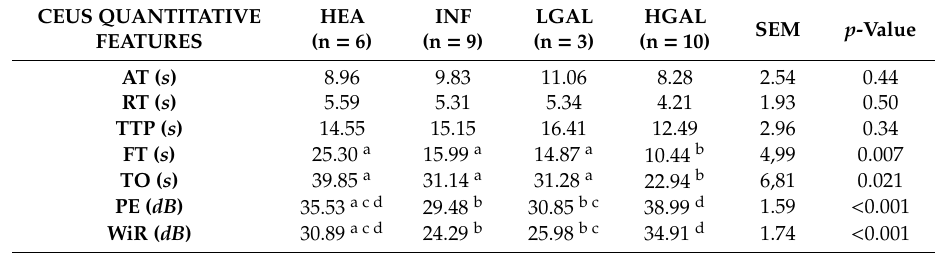
inflammatory (INF), low-grade alimentary lymphoma (LGAL) and high-grade alimentary lymphoma